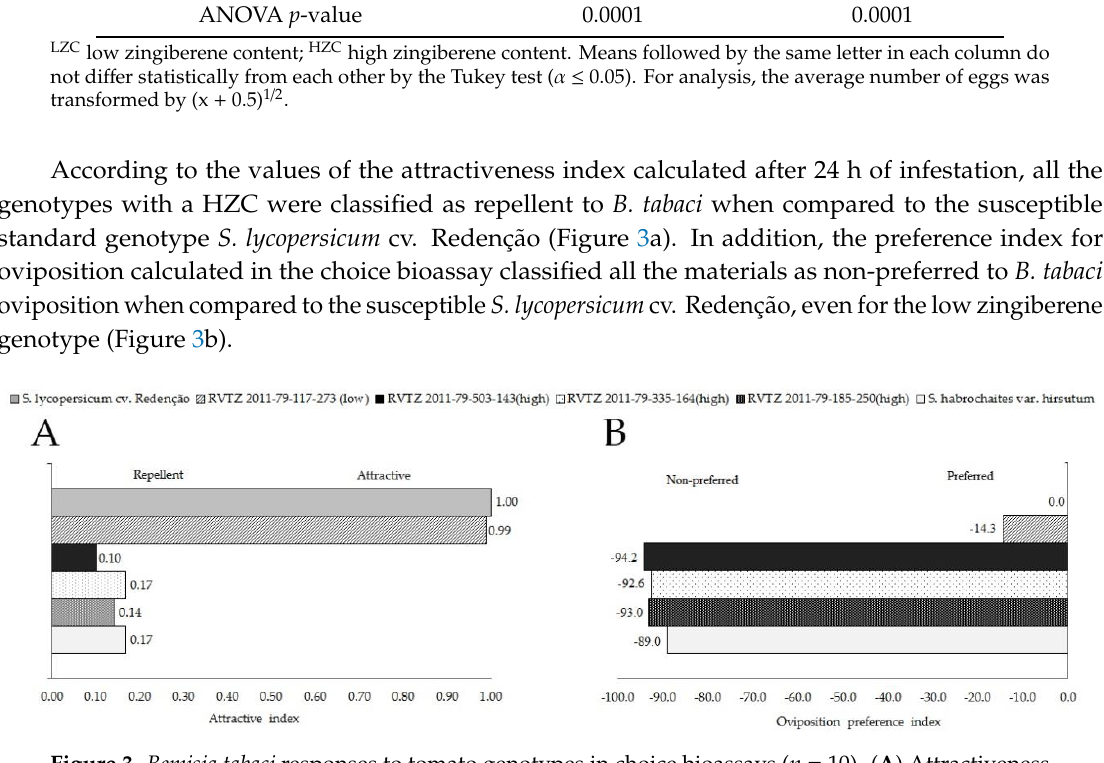
Figure 3. Bemisia tabaci responses to tomato genotypes in choice bioassays ( n = 10). ( A ) Attractiveness index of genotypes for adults of B. tabaci . ( B ) Oviposition preference index for B. tabaci in relation to